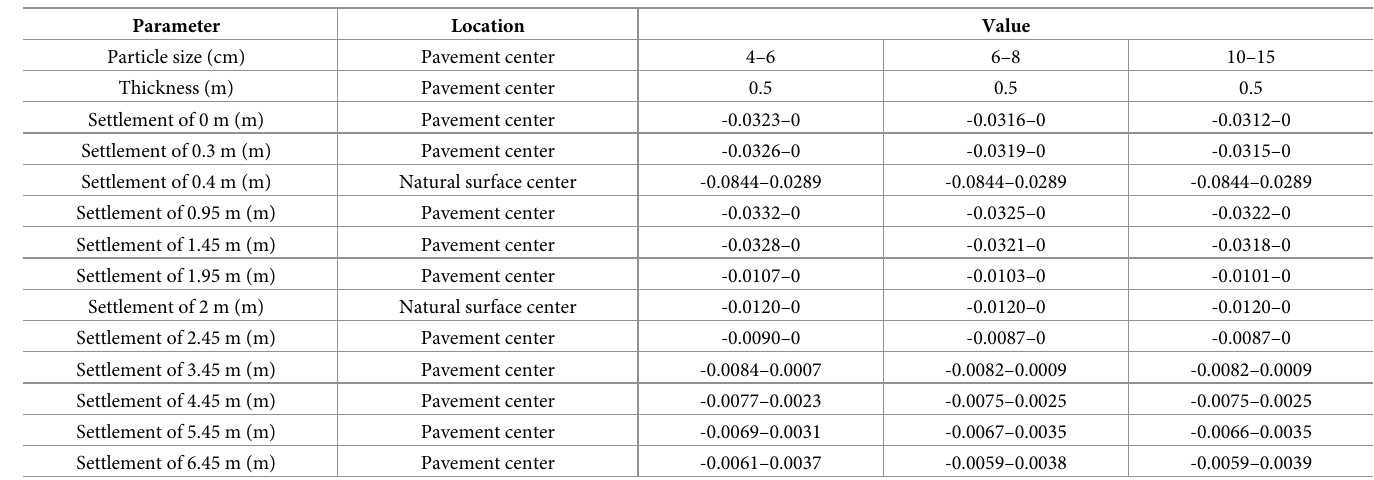
Table 12. Settlement of varied subbase layer under the static load of the aircraft.